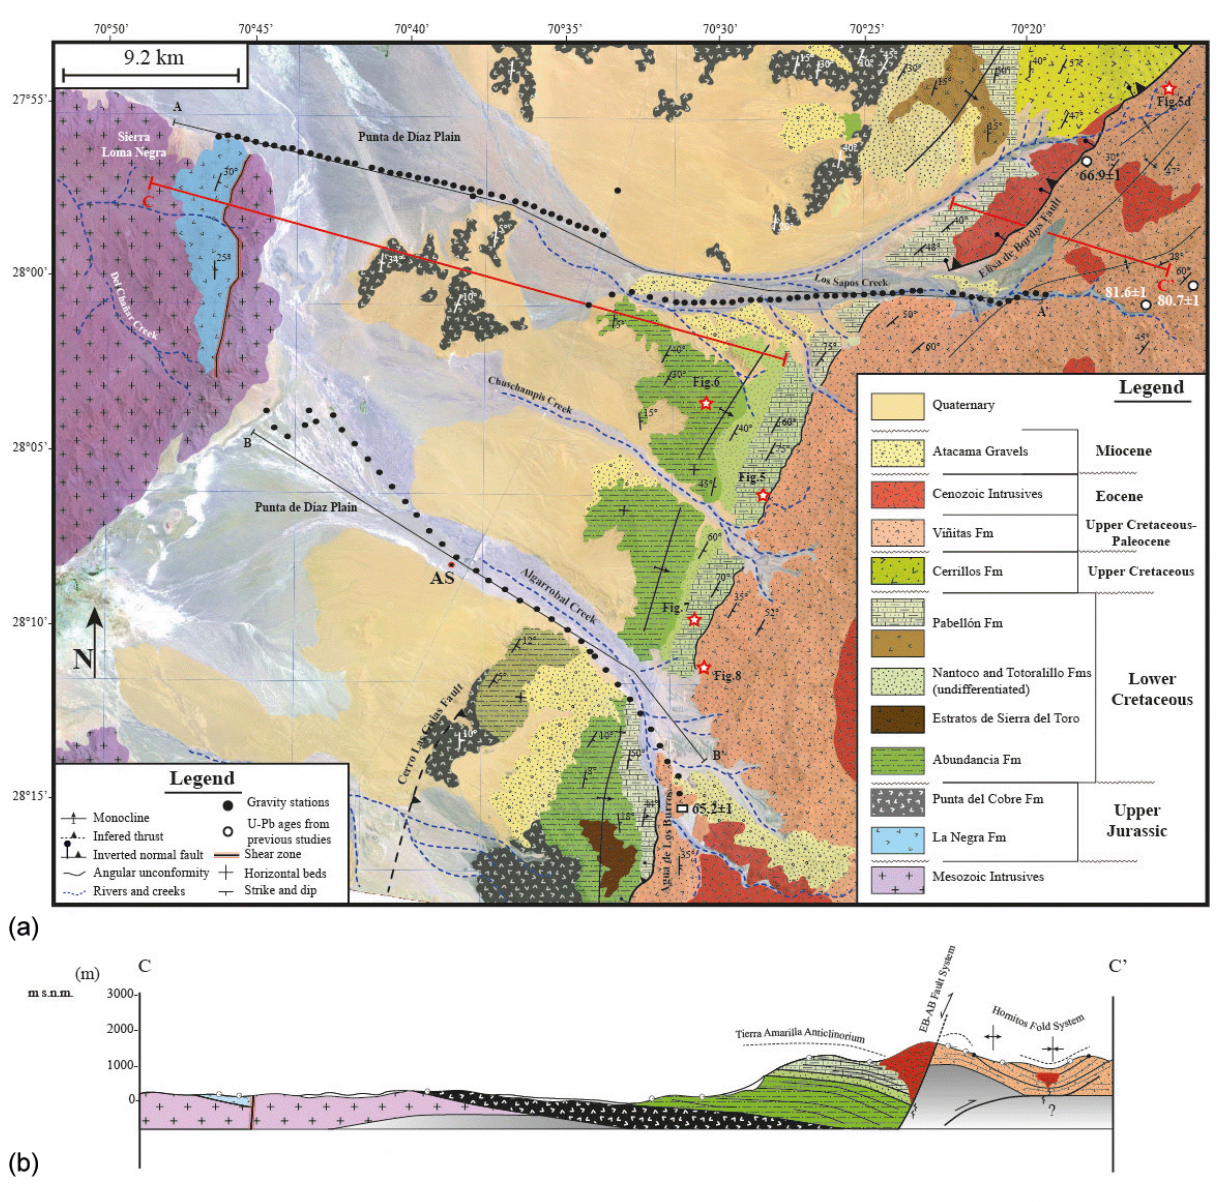
Figure 3. (a) Geological map of Chañarcillo Basin (Martínez et al., 2013, scale: 1 : 1 . 000000) and the distribution of the gravimetric transects (A–A (cid:48) , B–B (cid:48) ) acquired in this study; (b) schematic geological cross section showing the surface structures recognized along profile A–A (cid:48)